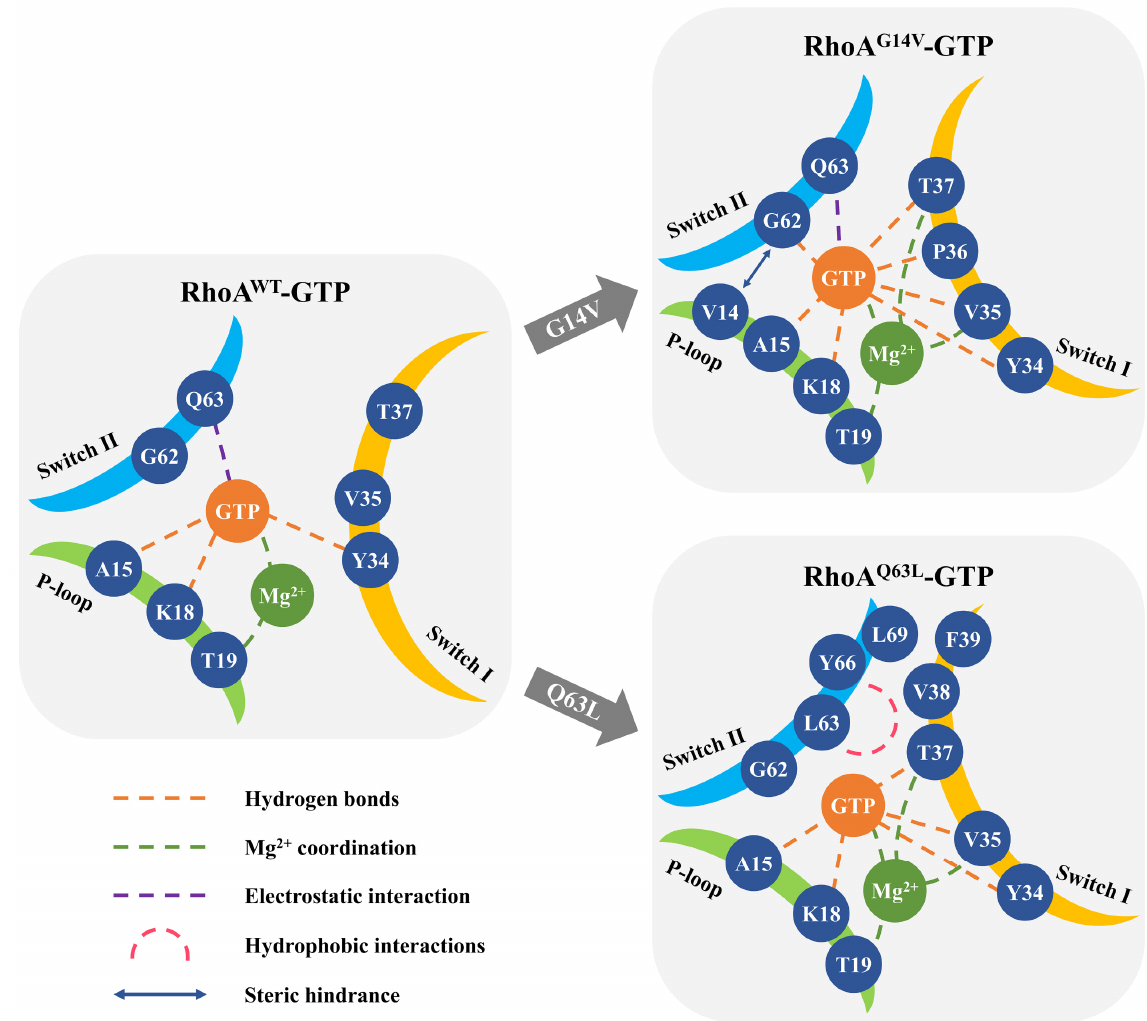
Figure 8. Schematic of the proposed activation mechanism of RhoA mutations G14V and Q63L. Generally, G14V and Q63L caused a similar inactive ‐ to ‐ active state transition in the switch I region, where the highly conserved T37 residue and the Mg 2+ ion played an im ‐ portant part (Figure 8). Among Rho and Ras GTPases, T37 (T35 in some other GTPases like Cdc42 and Ras) has been widely shown to mediate a critical hydrogen bond from its main chain NH group to γ‐ phosphate, which serves as the trigger for the switch I confor ‐ mational change [20]. In addition, T37 is required to bind RhoGAP, as an essential element in the catalysis of GTP hydrolysis by RhoA [50]. Here, we found that while the T37 and γ‐ phosphate mediated interaction was surprisingly absent in RhoA WT ‐ GTP, it was highly stable throughout the simulations of both RhoA G14V ‐ GTP and RhoA Q63L ‐ GTP, thus trigger ‐ ing the switch I region of the two mutants changing from the inactive to the active states and largely contributing to the conformational stabilization. Moreover, as it flipped inside to form a hydrogen bond with GTP, T37 was also involved in Mg 2+ coordination in RhoA Mut via its side chain together with another switch I residue V35, by which it could further correlate with residues on the P ‐ loop region. These additional interactions intro ‐ duced by G14V and Q63L through allosteric pathways together shifted switch I to the closed active conformation, thereby more favorable for downstream effector binding and partly accounting for the mutation ‐ dependent activation of RhoA protein.